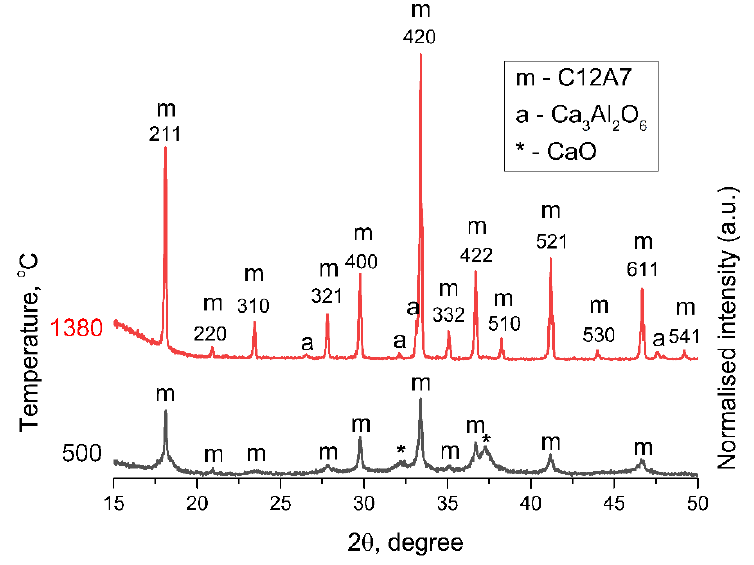
Figure 2. Comparison of diffraction patterns for samples obtained at 500 °C and 1380 °C in Ar at- mosphere.